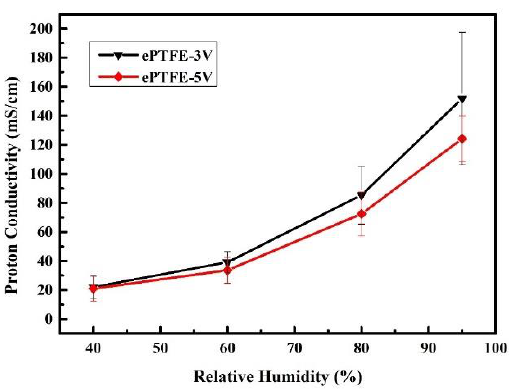
Figure 12. Proton conductivity of ePTFE-3 V vs. ePTFE-5 V at 80 °C and various relative humidi-